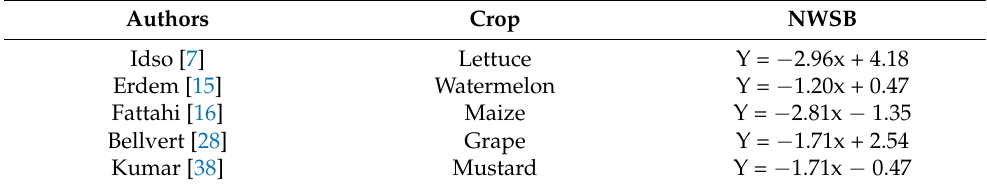
Table 1. Non-Water-Stressed Baselines (NWSB) obtained in the literature for different